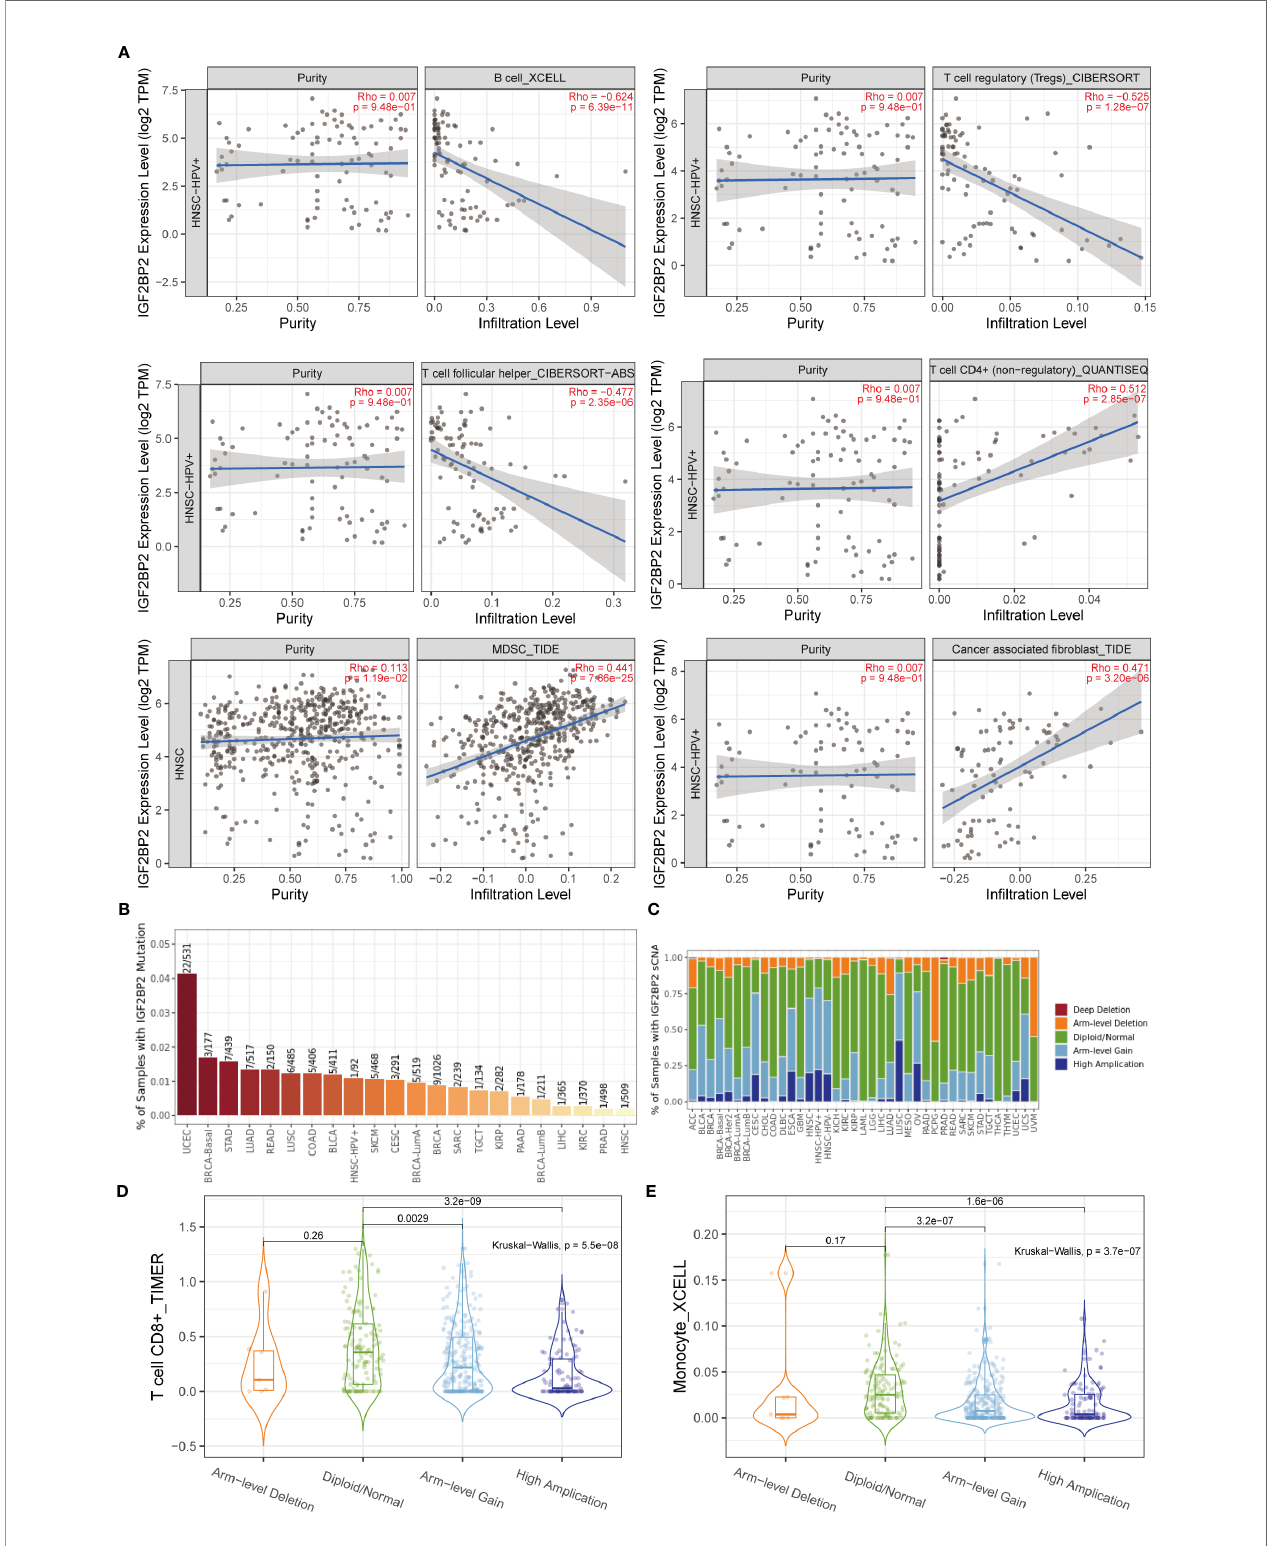
FIGURE 9 | Relationship between the tumor-immune microenvironment and IGF2BP2 expression. (A) The relationship between IGF2BP2 and immune cell in fi ltration in HNSCC. (B) Bar plot of IGF2BP2 mutation frequency in each TCGA cancer type. (C) The stacked bar chart shows the relative proportions of IGF2BP2 in different sCNA states in all tumor types. (D) Differential T cell CD8+ in fi ltration level in HNSCC (TIMER). (E) Differential monocyte in fi ltration level in HNSCC